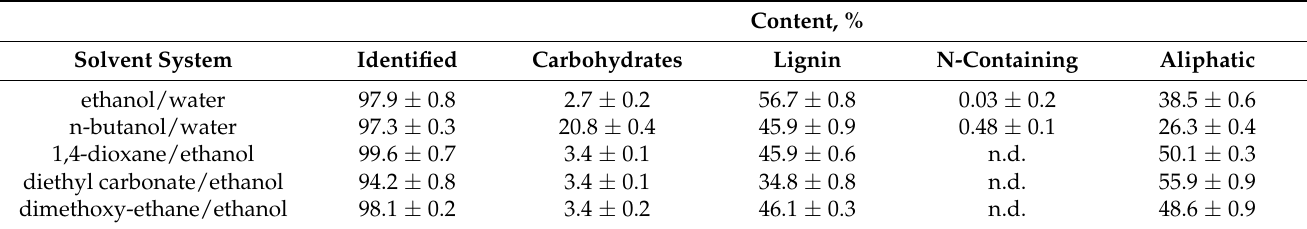
Table 3. The content of the major groups of biomass constituents-derived products in diagnostic volatiles of precipitated lignin-enriched fractions, according to Py-GC/MS data, normalized to 100%.